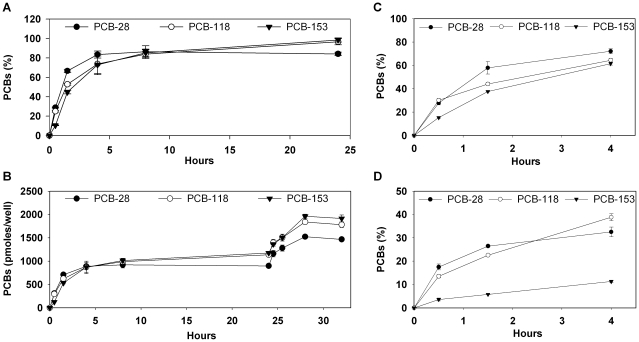
Efficient and differential accumulation patterns of PCBs -28, -118 and -153 in cultured adipocytes.
A. 3T3-L1 adipocytes were exposed for 24 h to a cocktail of PCBs-28, -118 and -153 (each congener at 500 nM). Cells were collected and quantified for PCB accumulation. Results are expressed as the % of accumulated PCBs in cells as compared to the amounts initially added in the medium. Adipocytes stored nearly the entire dose of PCBs within 24 h. B. After a first 24-hour incubation as described in A, 3T3-L1 adipocytes were incubated with a second dose of PCBs-28, 118 and 153 added at a final concentration of 500 nM. Cells were collected and quantified for PCB accumulation at each indicated time of incubation. Results are expressed as pmoles of accumulated PCBs in cells. Although already contaminated by the first dose, adipocytes again stored up to 80% of the second amount added in the medium. 3T3-L1 adipocytes (C) and differentiated adipocytes derived from mouse embryonic fibroblasts (MEFs) obtained from WT mice (D) were independently incubated during 4 h with PCBs-28, -118 and -153 added at a final concentration of 500 nM, and quantified for accumulated PCBs. Results are expressed as the % of accumulated PCBs in cells as compared to the amounts initially added in the medium. Each PCB-congener entered the cells with its proper accumulation profile, governed by its own physico-chemical properties.